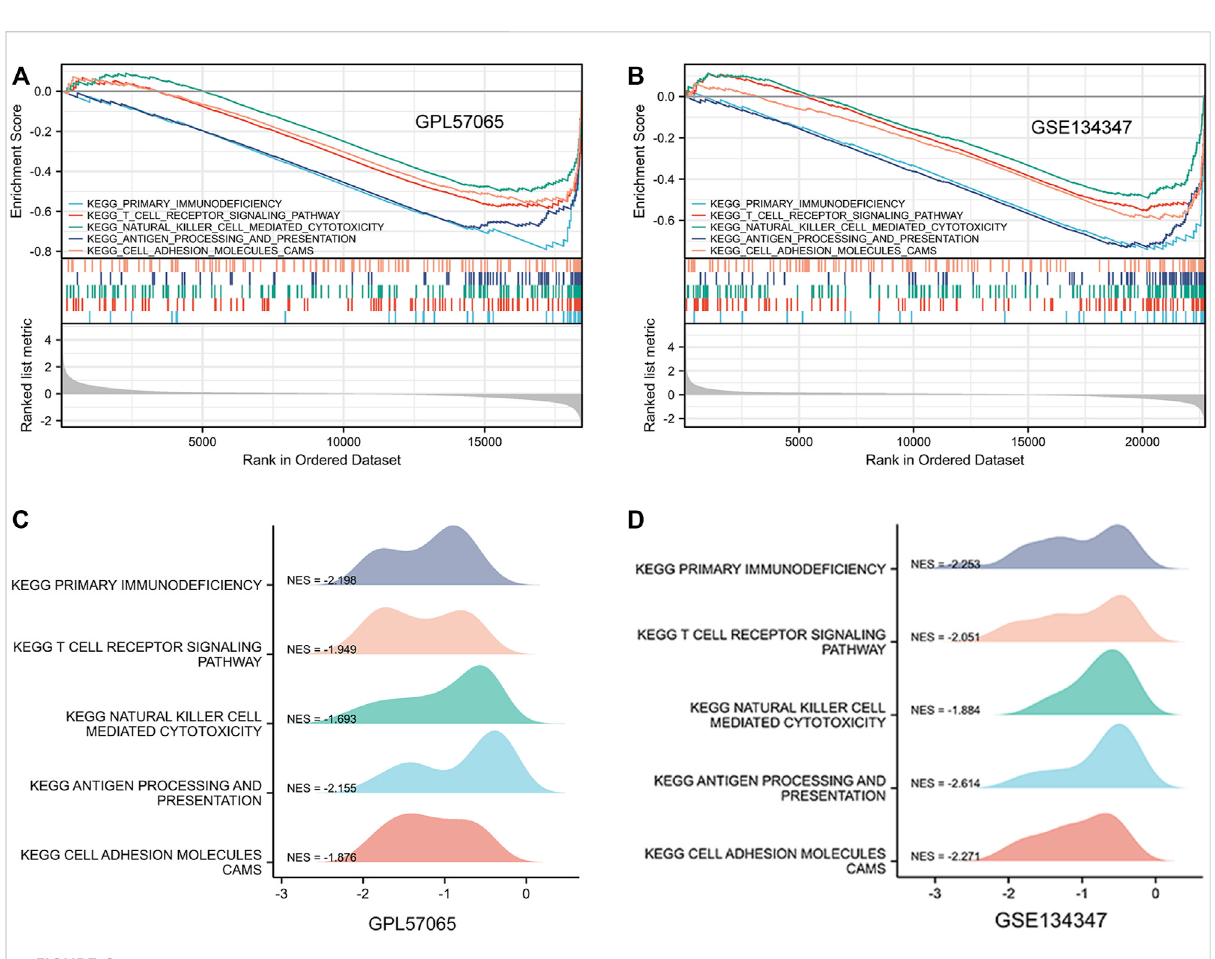
FIGURE 6 Gene set enrichment analysis (GSEA) was used to analyze the KEGG pathways enrichment in different groups. (A) GSEA using three data sets of GPL57065. (B) GSEA using GSE134347. (C) GPL57065 ridge plot. (D) GSE134347 ridge